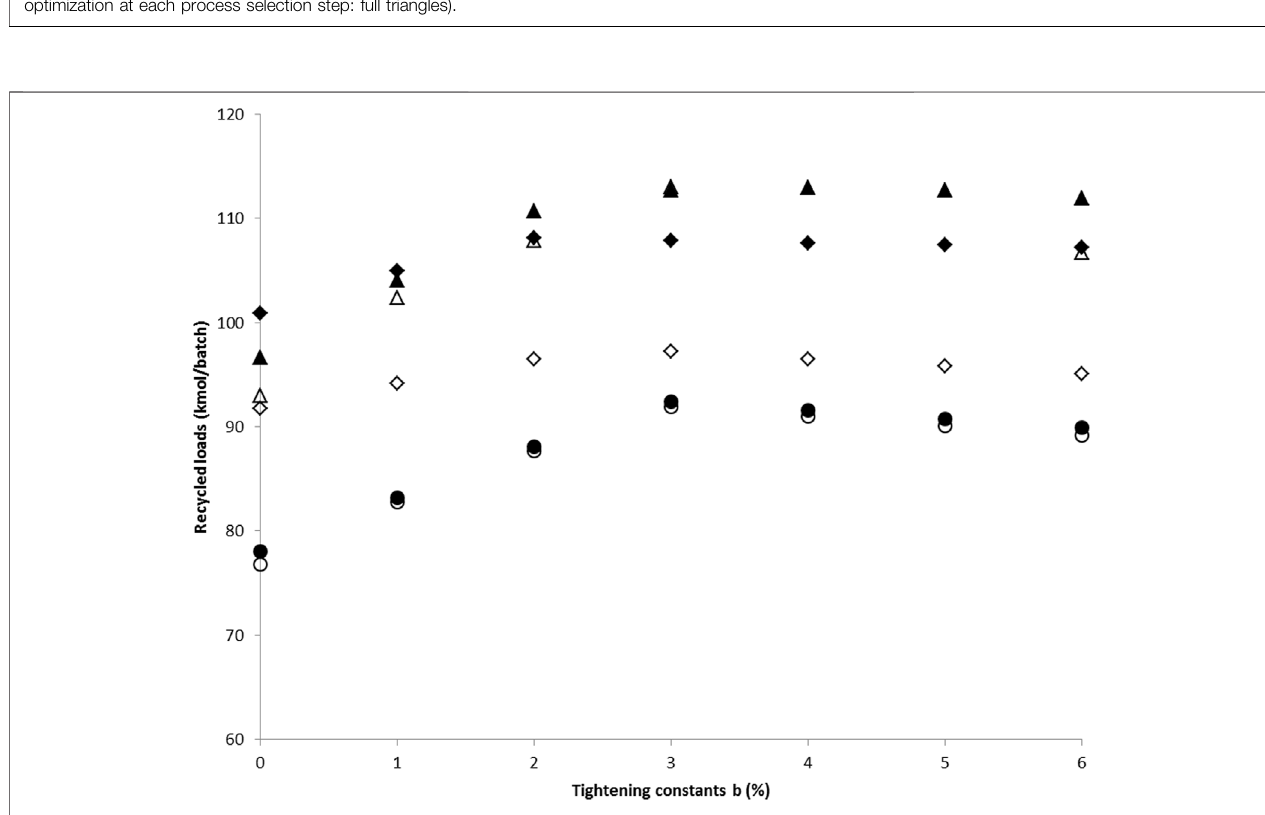
FIGURE6| Totalrecycled loadsofthe SMI RPM method inthe case study-1 for different tightening constants and MAIconstraintsin SK1 (single-variable sequential optimization at each process selection step and MAI constraint 1%: hollow circles; single-variable sequential optimization at each process selection step and MAI constraint 5%: hollow rhombuses; single-variable sequential optimization at each process selection step and MAI constraint 10%: hollow triangles; multi-variable simultaneous optimization at each process selection step and MAI constraint 1%: full circles; multi-variable simultaneous optimization at each process selection step and MAI constraint 5%: full rhombuses; multi-variable simultaneous optimization at each process selection step and MAI constraint 10%: full triangles).